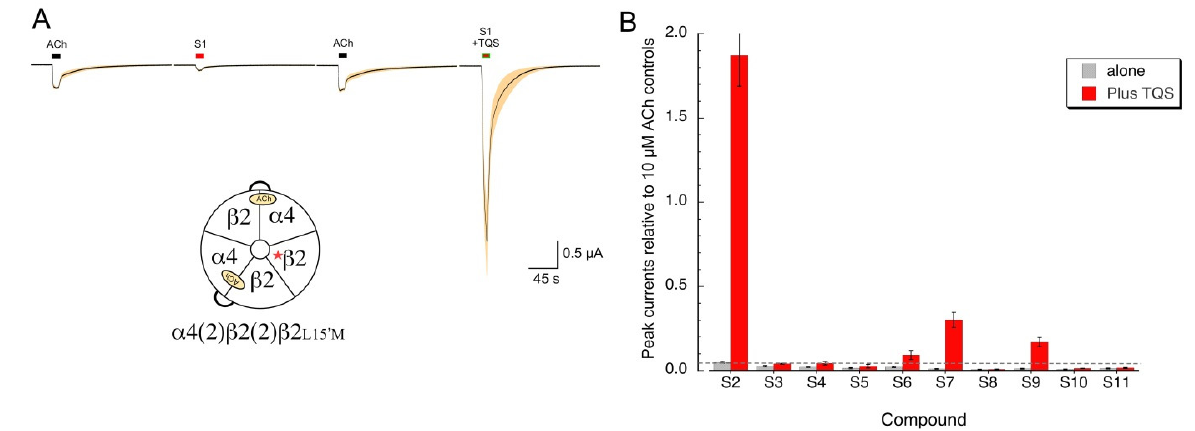
Figure 8. Silent agonism of an α 4 β 2 mutant receptor that is sensitive to the α 7 PAM TQS. ( A ) The averaged raw data of responses of eight oocytes expressing the β 2-6- α 4 concatamer and the β 2L15’M mutant to 100 µM of the sulfonium agonist S1 , applied alone or co-applied with 30 µM racemic TQS. The insert shows a schematic of the subunit configuration predicted for these receptors, with a single mutant β 2 subunit outside of the two pairs of α 4 and β 2 subunits that would form the ACh binding sites. ( B ) Evaluation of the effects of the sulfonium compounds, applied alone at 100 µ M or co-applied with 30 µM TQS to α 4(2) β 2(2) β 2L15’M receptors. The dashed line represents our reliable limit of detection for a peak current response relative to application artifacts, which, for these experiments, was 20 nA. Data are the averages of seven to eight oocytes (±SEM), normalized to 10 µM ACh control responses from the same cells.